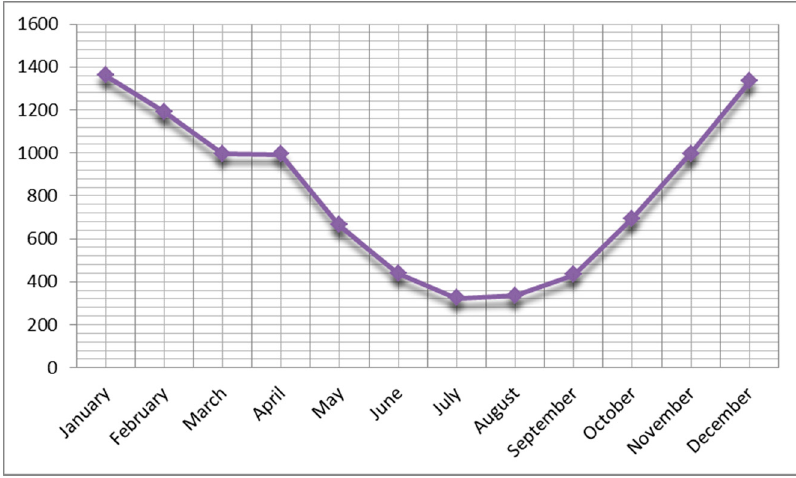
Figure 5. Distribution of prevalence of rotavirus gastroenteritis by month.